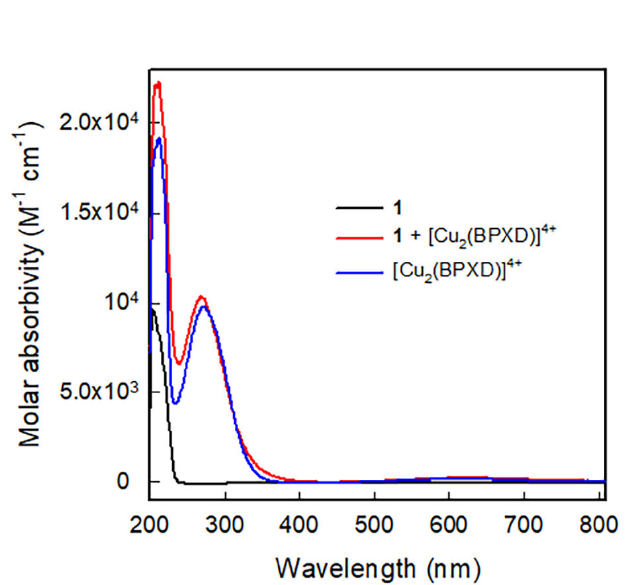
Figure 3. UV-vis spectra of: a 1.0 × 10 − 4 M solution of compound 1 (black line), same solution after addition of an equimolar amount of [Cu 2 (BPXD)] 4+ (red line), a 1.0 × 10 − 4 EtOH solution of [Cu 2 (BPXD)] 4+ (blue